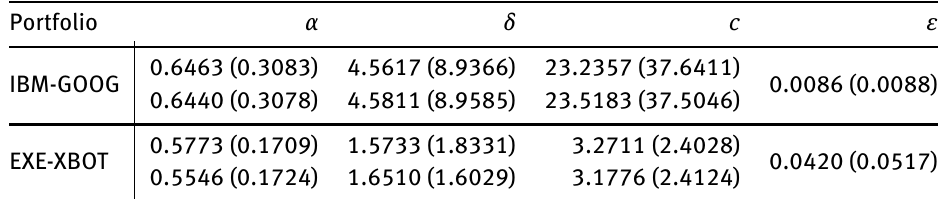
Table 1: Average estimated parameters (with standard deviations in brackets) for negative (first line) and positive (second line) processes of the portfolios under consideration over the whole